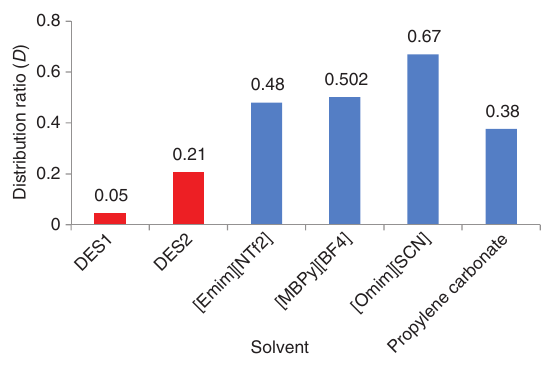
Figure 6: Comparison between the distribution ratio obtained in this work and that reported for other solvents for the same